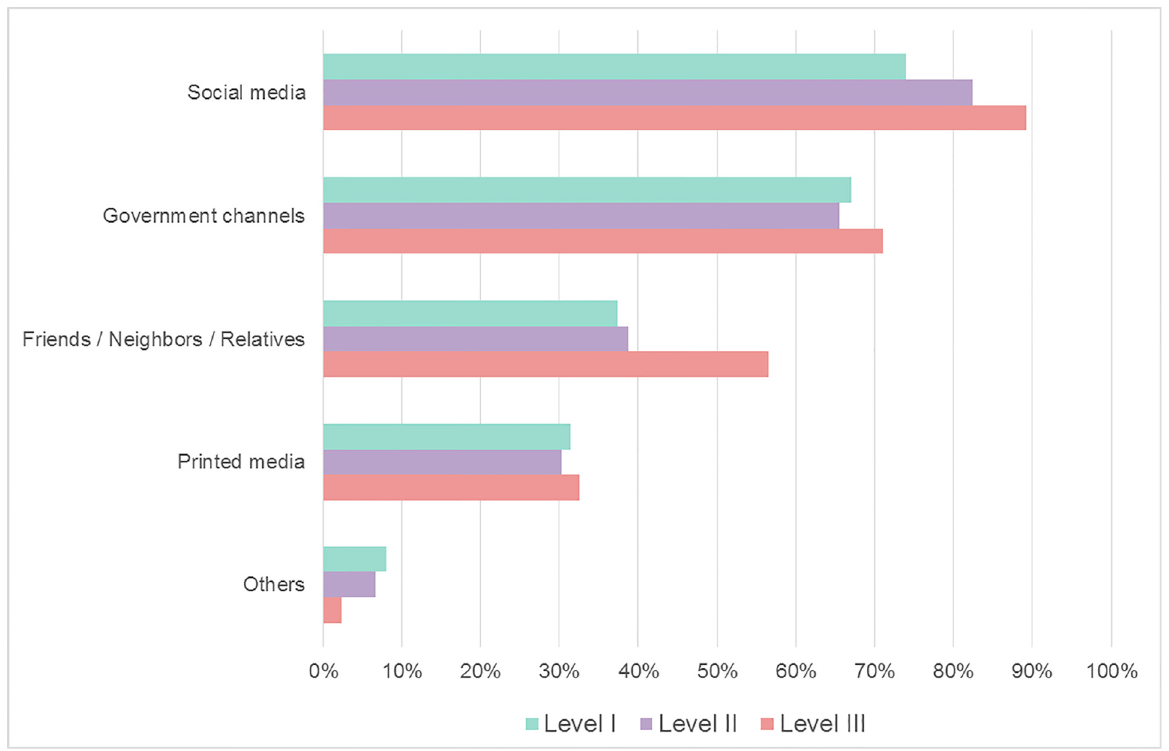
Figure 2. Information source of COVID-19 among three different lockdown levels. Level I, not restricted; level II, partially restricted; level III, restricted.